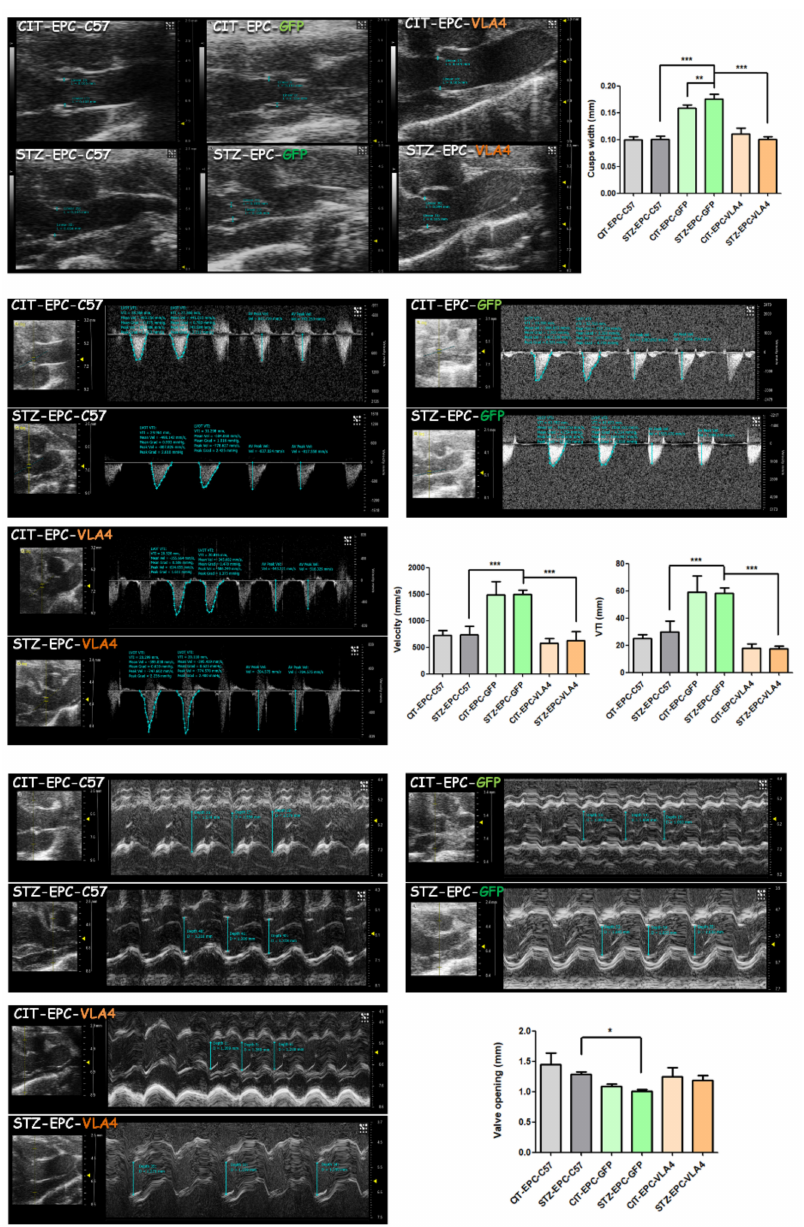
Figure 3. Morphologic and functional echocardiographic measurements. Shown are represen- tative images of B-mode measurements of leaflets width and subsequential statistical analysis ( Upper panel ); pulsed-wave Doppler mode (PW Doppler-mode) measurements of the left ventricle outflow tract (LVOT), velocity-time integral (VTI) and Velocity ( Middle panel ); and M-mode measure- ments of maximum systolic valve opening ( Lower panel ). ANOVA, Bonferroni post-test were applied: * p < 0.05, ** p < 0.01, *** p <